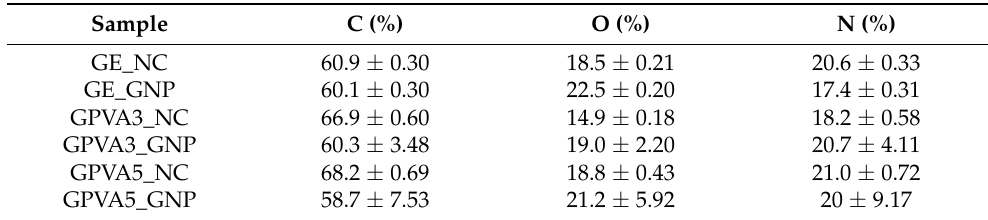
Table 2. Elemental analysis with EDX. All hydrogels possessed different elemental compositions including oxygen, carbon, and